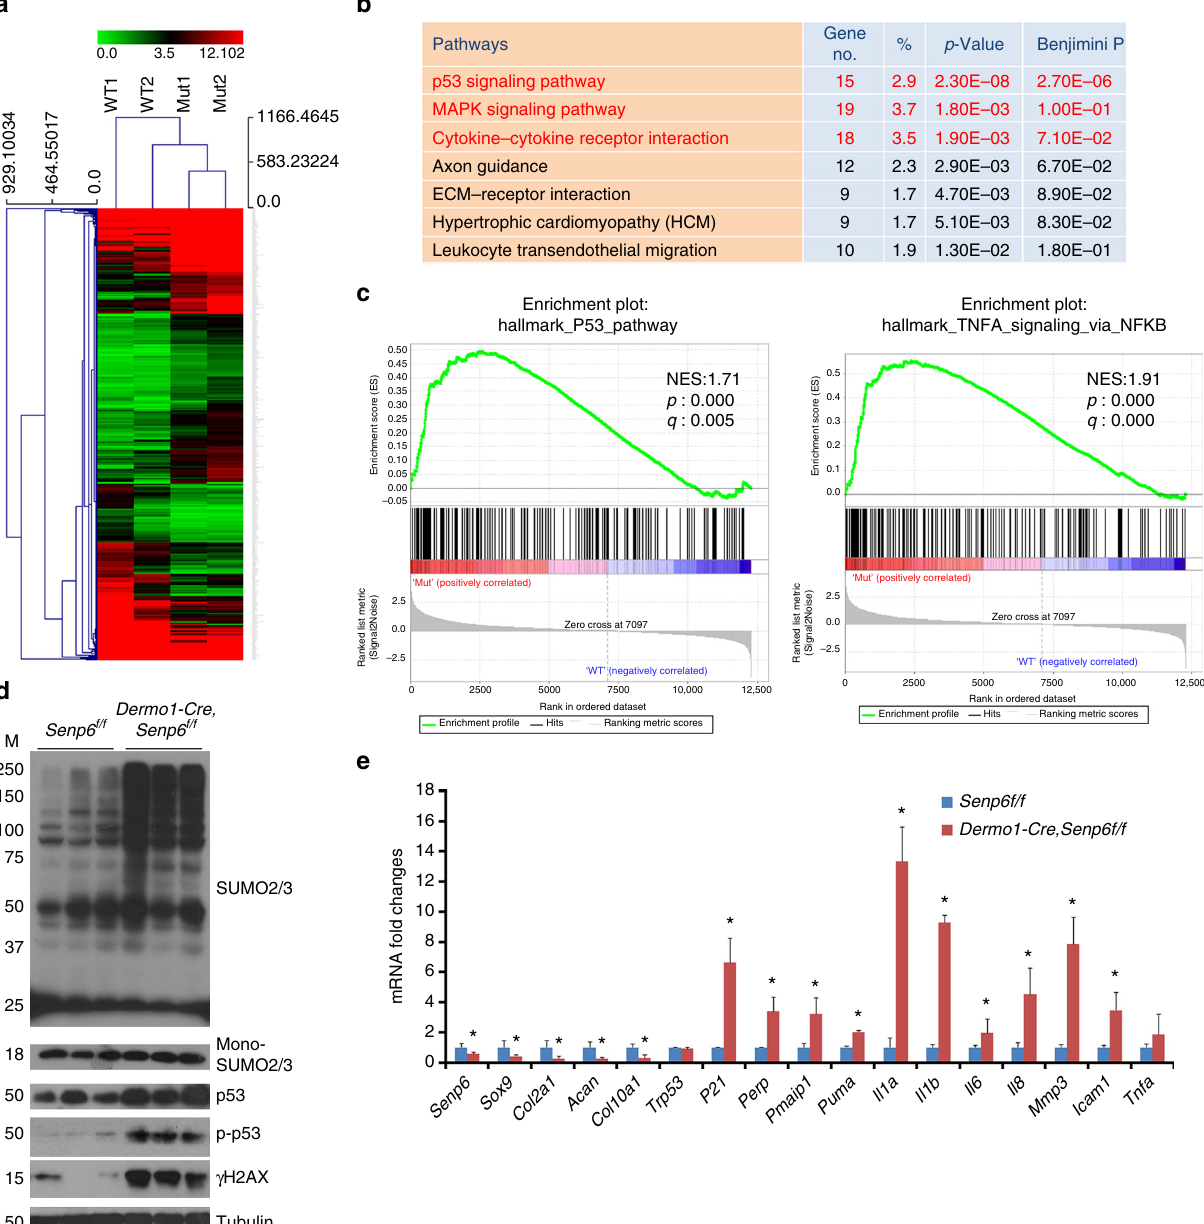
Fig. 4 Senp6 loss activated p53 signaling pathway and SASP. a Heatmap of RNA-seq gene expression pro fi les comparing Dermo1-Cre;Senp6 f/f and control primary rib chondrocytes ( n = 2). b Up-regulated pathways based on DAVID GO analyses ( p -values: Fisher Exact/EASE Score). c Enriched p53 pathway and TNF α -signaling-via-NF κ B pathway in Dermo1-Cre;Senp6 f/f by GESA analysis (NES normalized enrichment score; p : nominal p -value; q : false discovery rate q -value). d Dermo1-Cre;Senp6 f/f rib cartilage (E18.5) showing higher total SUMO2/3-modi fi ed proteins, total and phosphorylated (S15) p53, and γ H2AX relative to controls ( n = 3). e Chondrocyte differentiation and proliferation markers, p53 downstream targets that promote apoptosis and senescence, and SASP markers were augmented in the rib cartilage of E18.5 Dermo1-Cre;Senp6 f/f mice ( n = 3; error bars = standard deviation, * p < 0.05, relative to controls, Student ’ s t